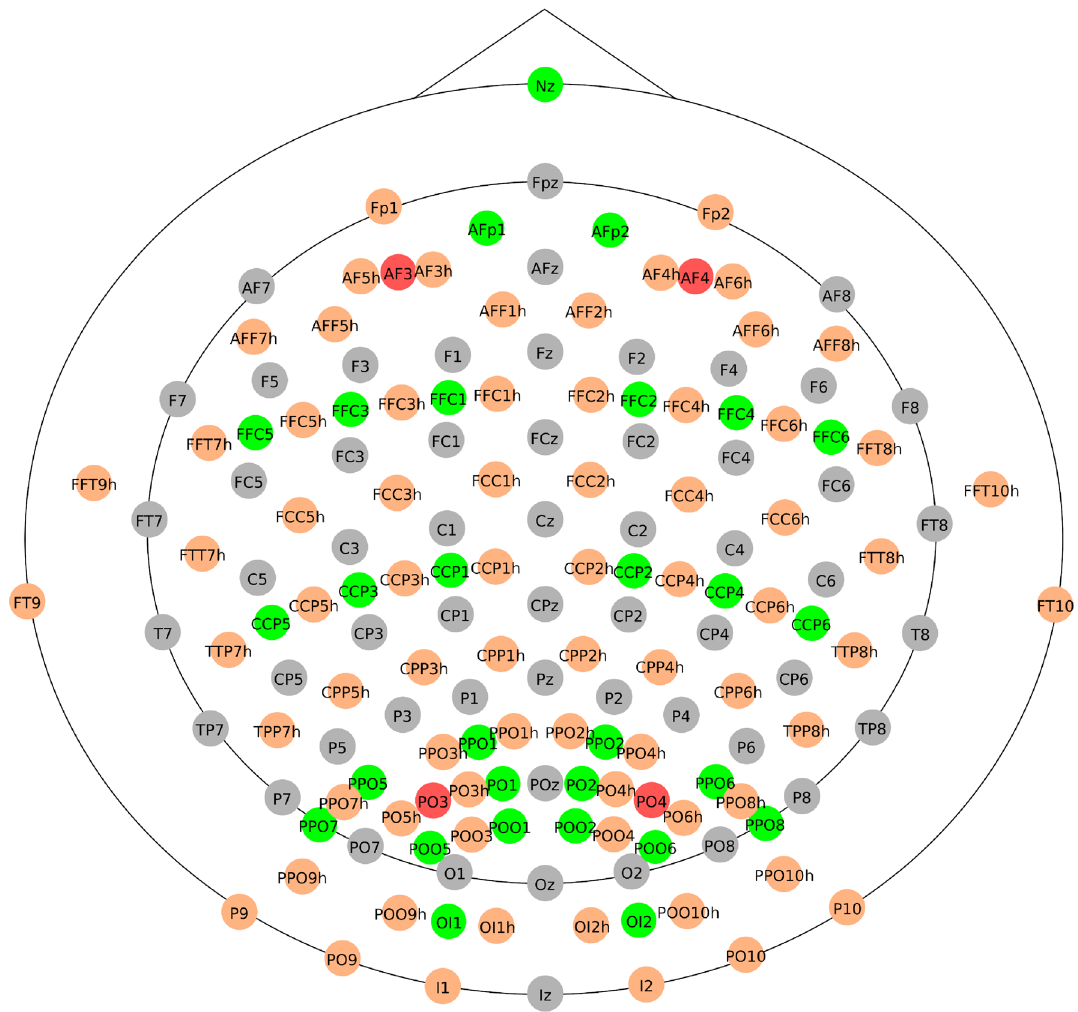
Figure 5. Location and names of the 161 scalp electrodes included in the New York head model 40 . Red and gray circles represent the subset of 60 electrodes, and orange and gray circles represent the subset of